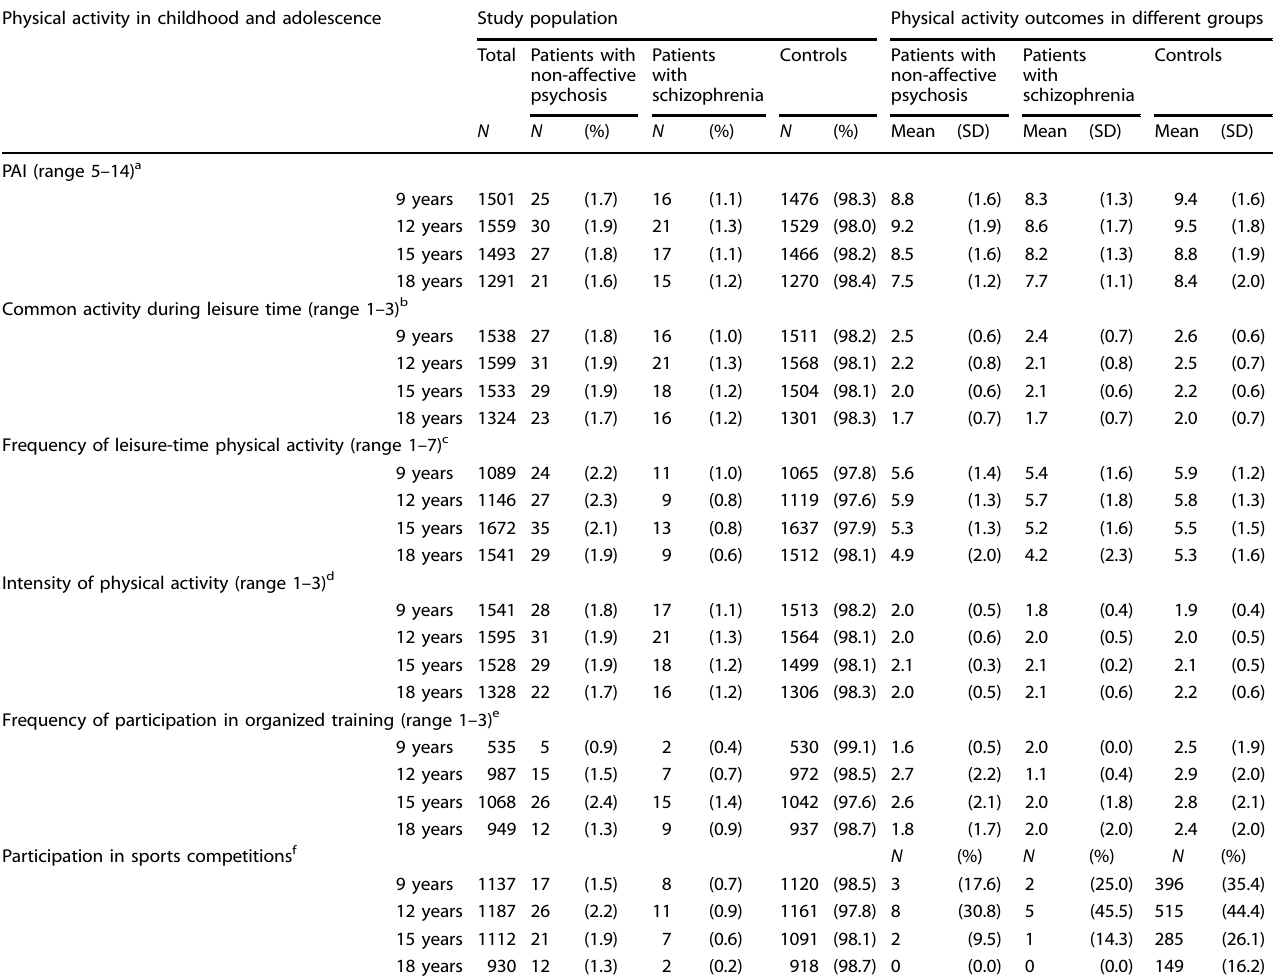
Table 1. Physical activity in childhood and adolescence (9 – 18 years, during years 1980 – 1986) in the groups with later development of schizophrenia or any non-affective psychosis, and controls with no psychiatric diagnoses during follow-up years 1980 –